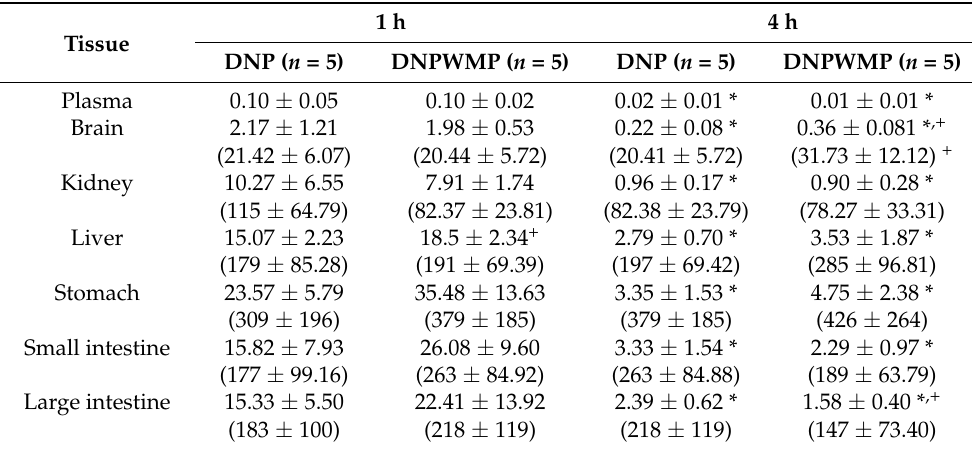
Table 2. Concentrations ( µ g/mL for plasma and µ g/g for tissue) or T/P ratios of donepezil after oral administration of DNP (as 10 mg/kg of donepezil) with and without WMP (300 mg/kg) to mice ( n = 5 for each